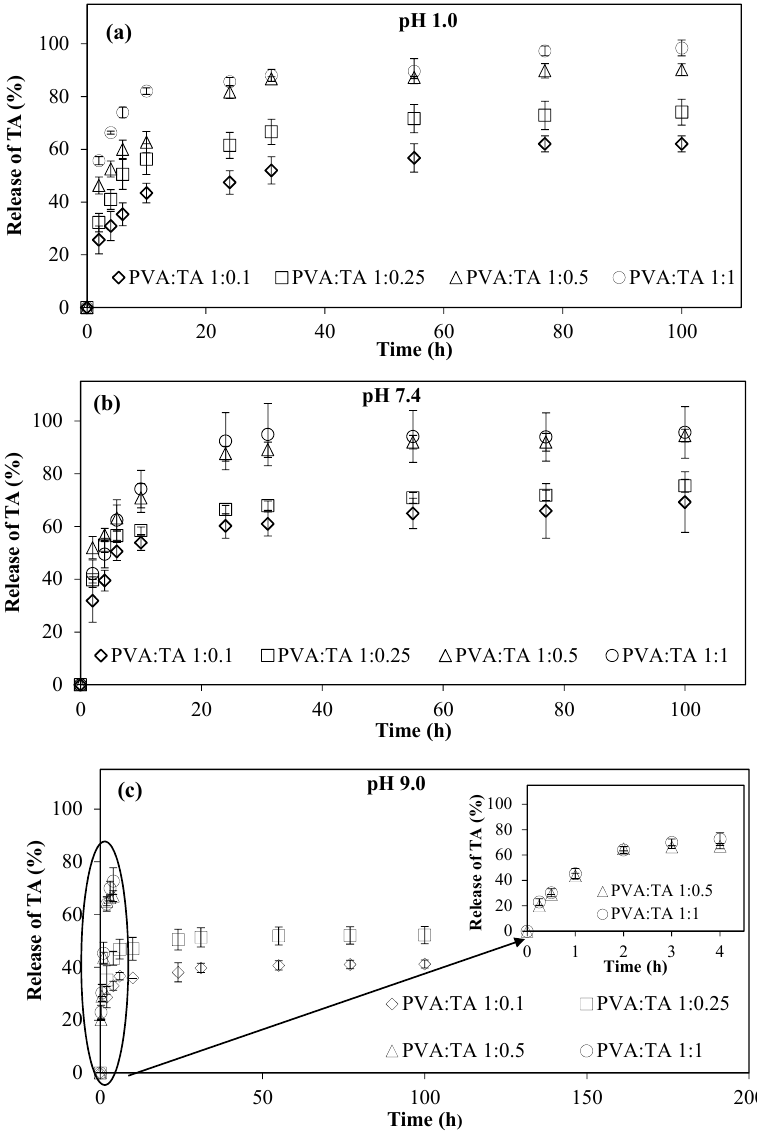
Figure 3. TA release profiles from PVA:TA cryogel composites at ( a ) pH 1.0, ( b ) pH 7.4, and ( c ) pH 9.0.